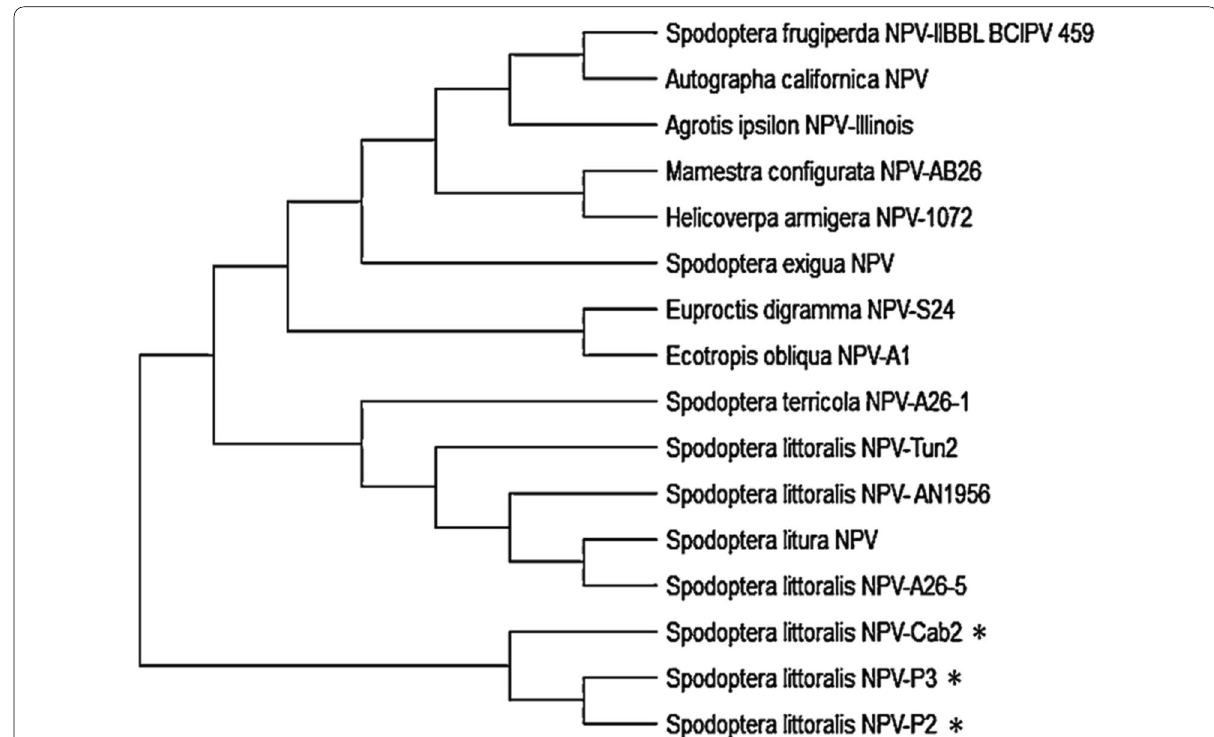
Fig. 2 Phylogenetic inference of relationships among isolates of NPV based on polyhedrin nucleotide sequence alignments. The evolutionary history was inferred using the neighbor-joining method. The SpliNPV isolates Cab2, P2 and P3 are indicated by black asterisks